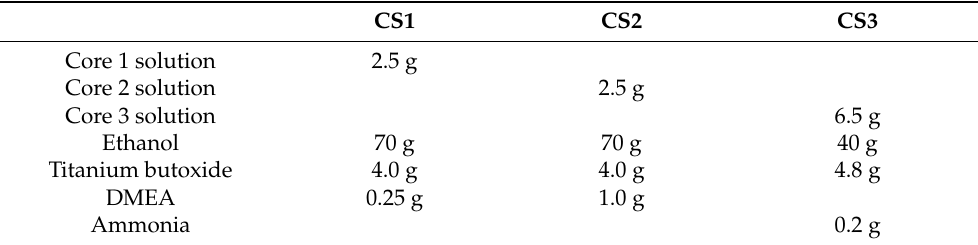
Table 1. Core-shell titania nanoparticle synthesis